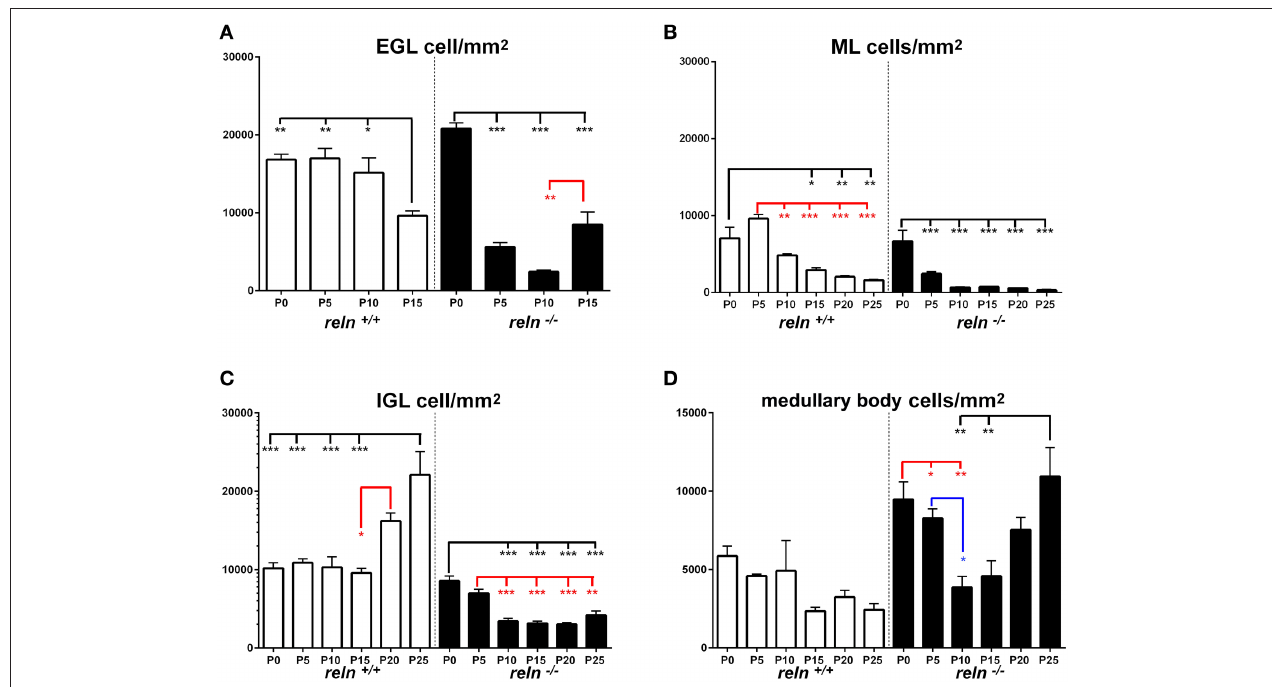
FIGURE 4 | Comparison of TCD within genotypes. Cortical layers (A–C) , medullary body (D) . EGL, external granular layer; ML, molecular layer; P, postnatal age; TCD, total cell density after nuclear stain. One-way ANOVA with multiple comparisons; error bars indicate SEM; *** P < 0.001; ** P < 0.01; * P < 0.05.